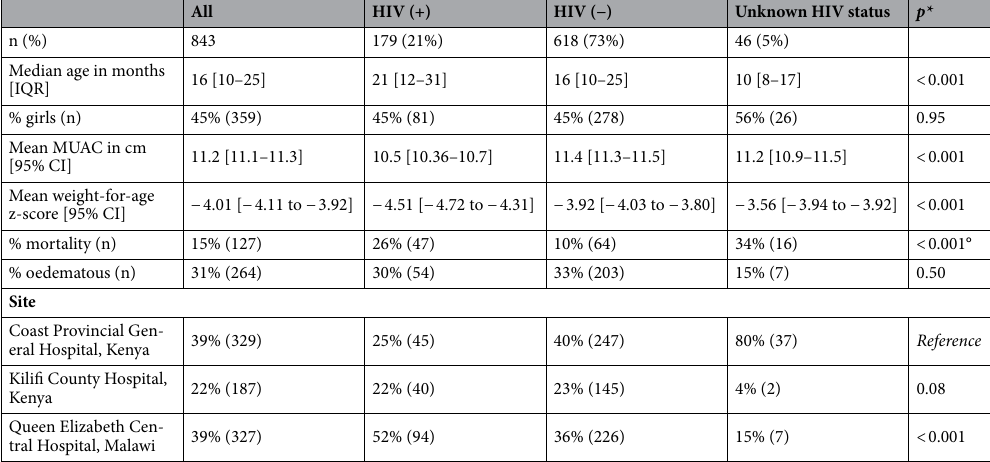
Table 1. Descriptive characteristics of the study participants. *Comparison between HIV(+) and HIV(−). °Adjusted for age, sex and site of